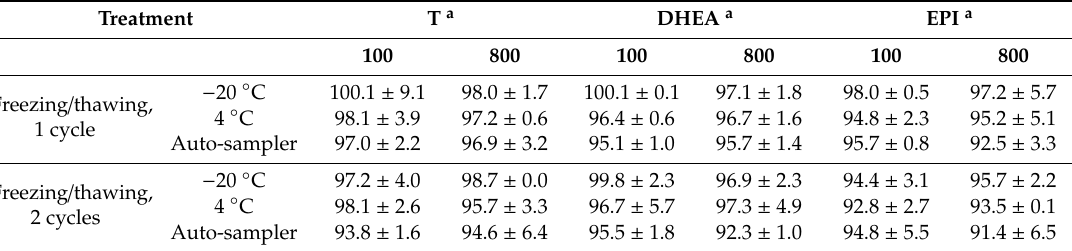
Table 7. Stability of T, DHEA and EPI in the short